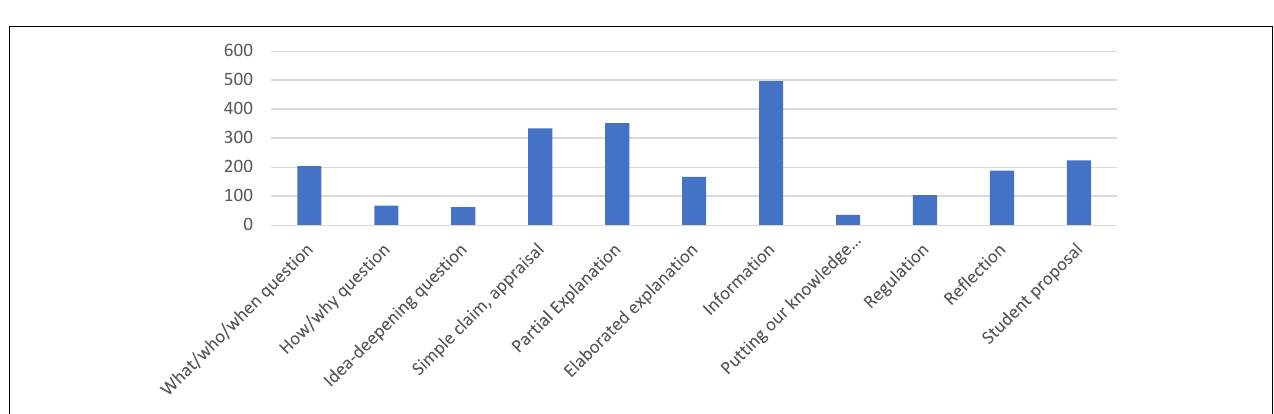
FIGURE 6 | The distribution of students’ discourse moves in grade 2 that grade 3 reflected on.